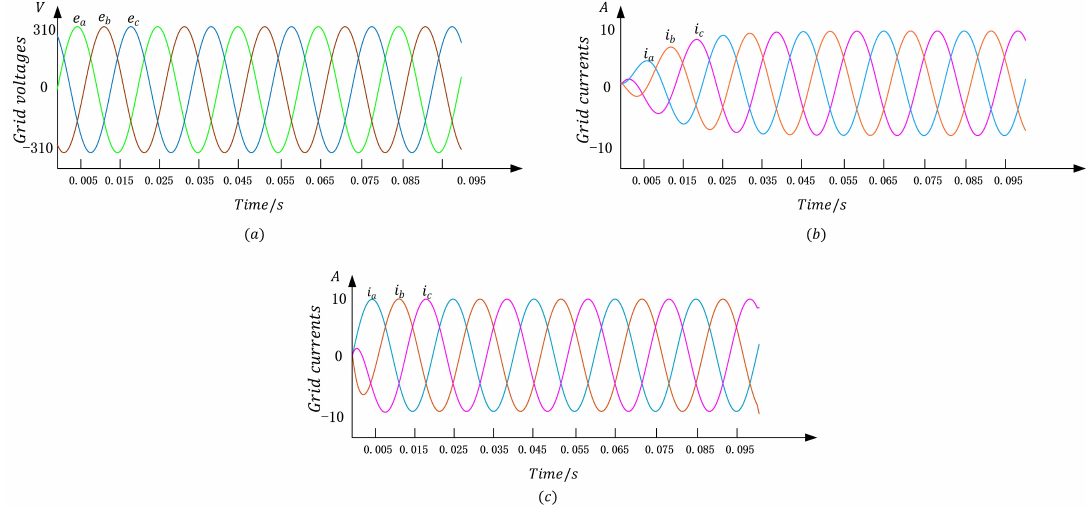
Figure 4. Grid voltages ( a ). Grid currents of PI closed-loop control ( b ). Grid currents of ADP closed-loop control ( c